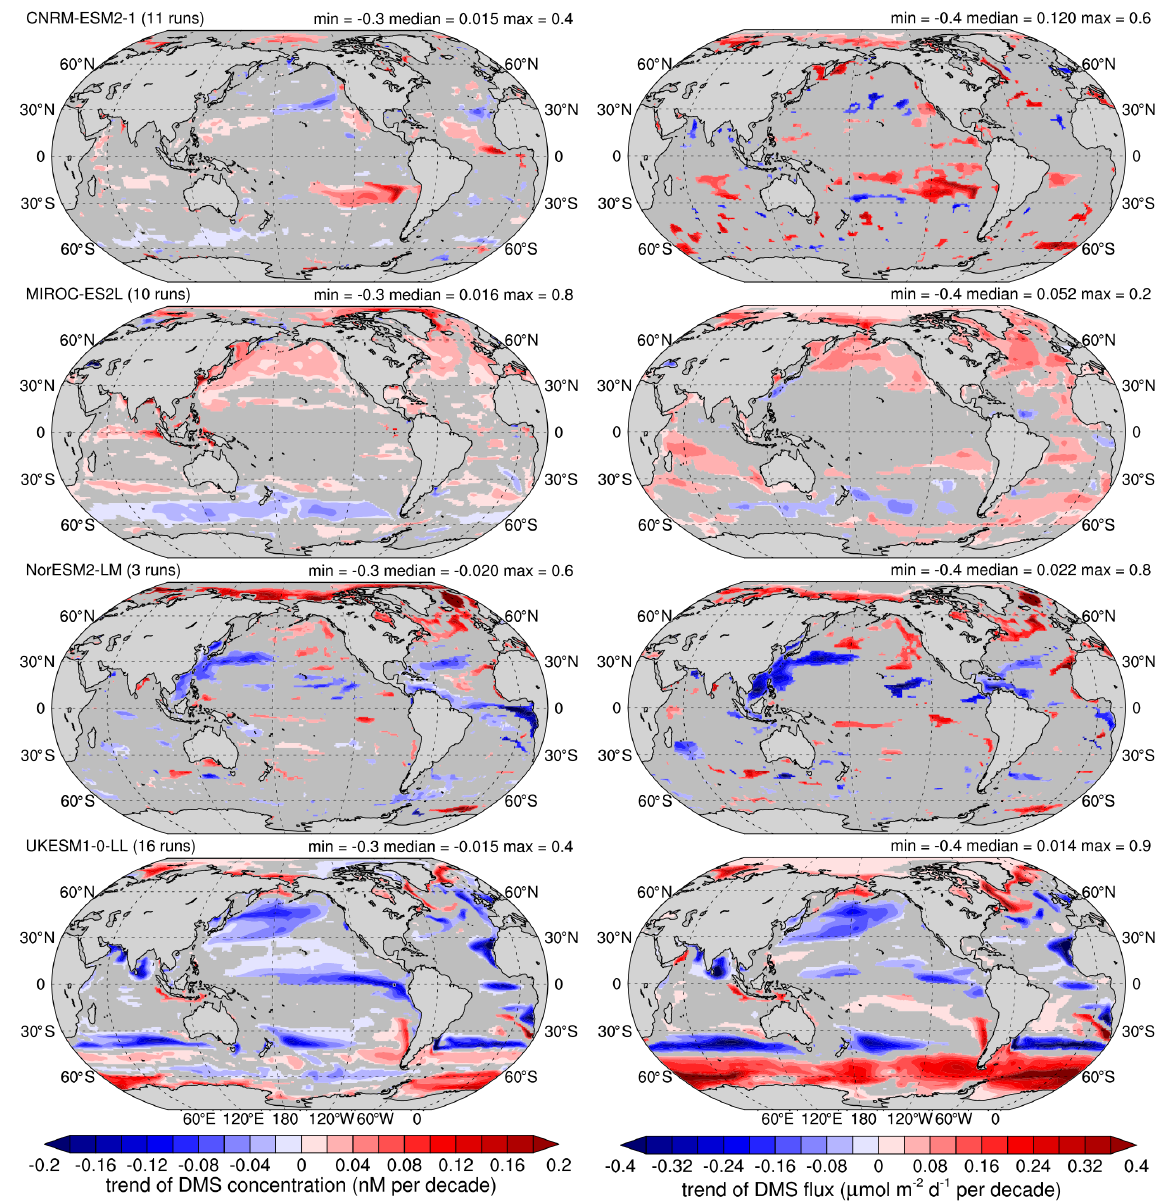
Figure 11. Mean trends over 1980–2009: left column is surface ocean DMS concentration (nMdecade − 1 ), and right column is DMS flux into the atmosphere (µmolm − 2 d − 1 decade − 1 ). Shaded areas denote a statistical significance below the 90%